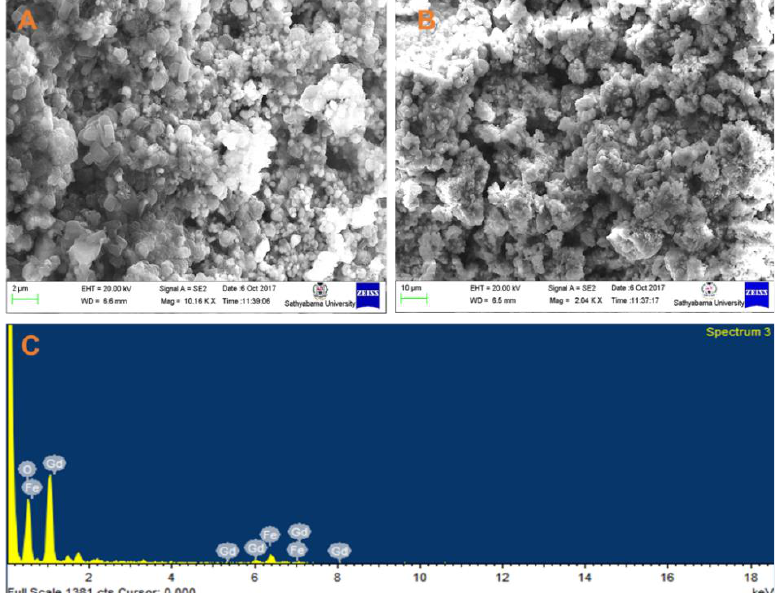
Figure 4. FE-SEM image of GdFeO 3 nanoparticles annealed at a temperature of 800 °C ( A , B ) and the corresponding EDAX mapping ( C ).